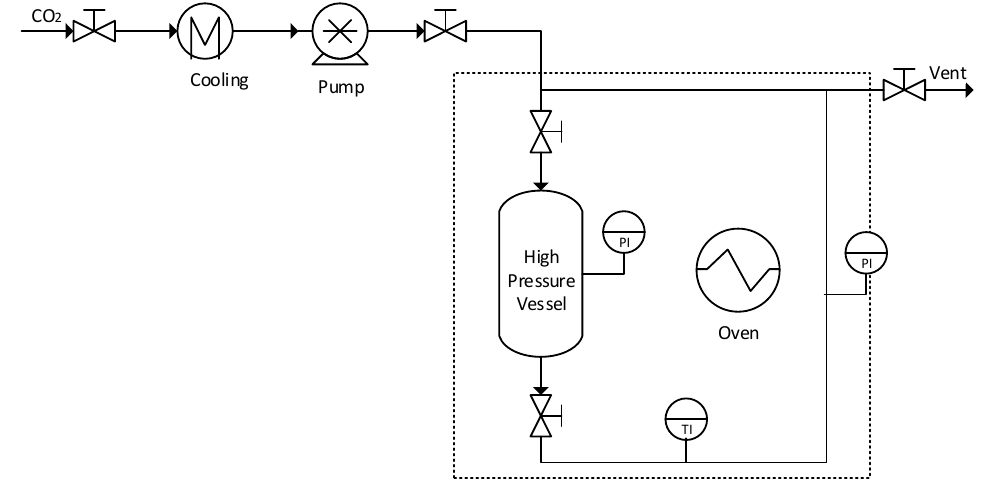
Figure 1. Silica aerogels drying plant.